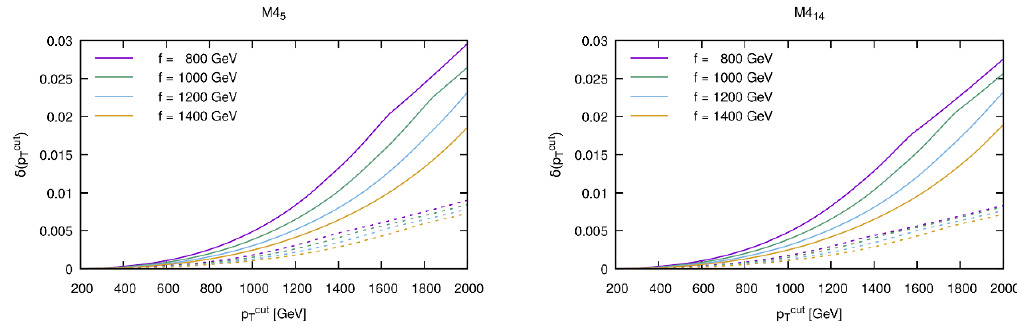
Figure 20 . The distribution (cid:14) ( p cut section